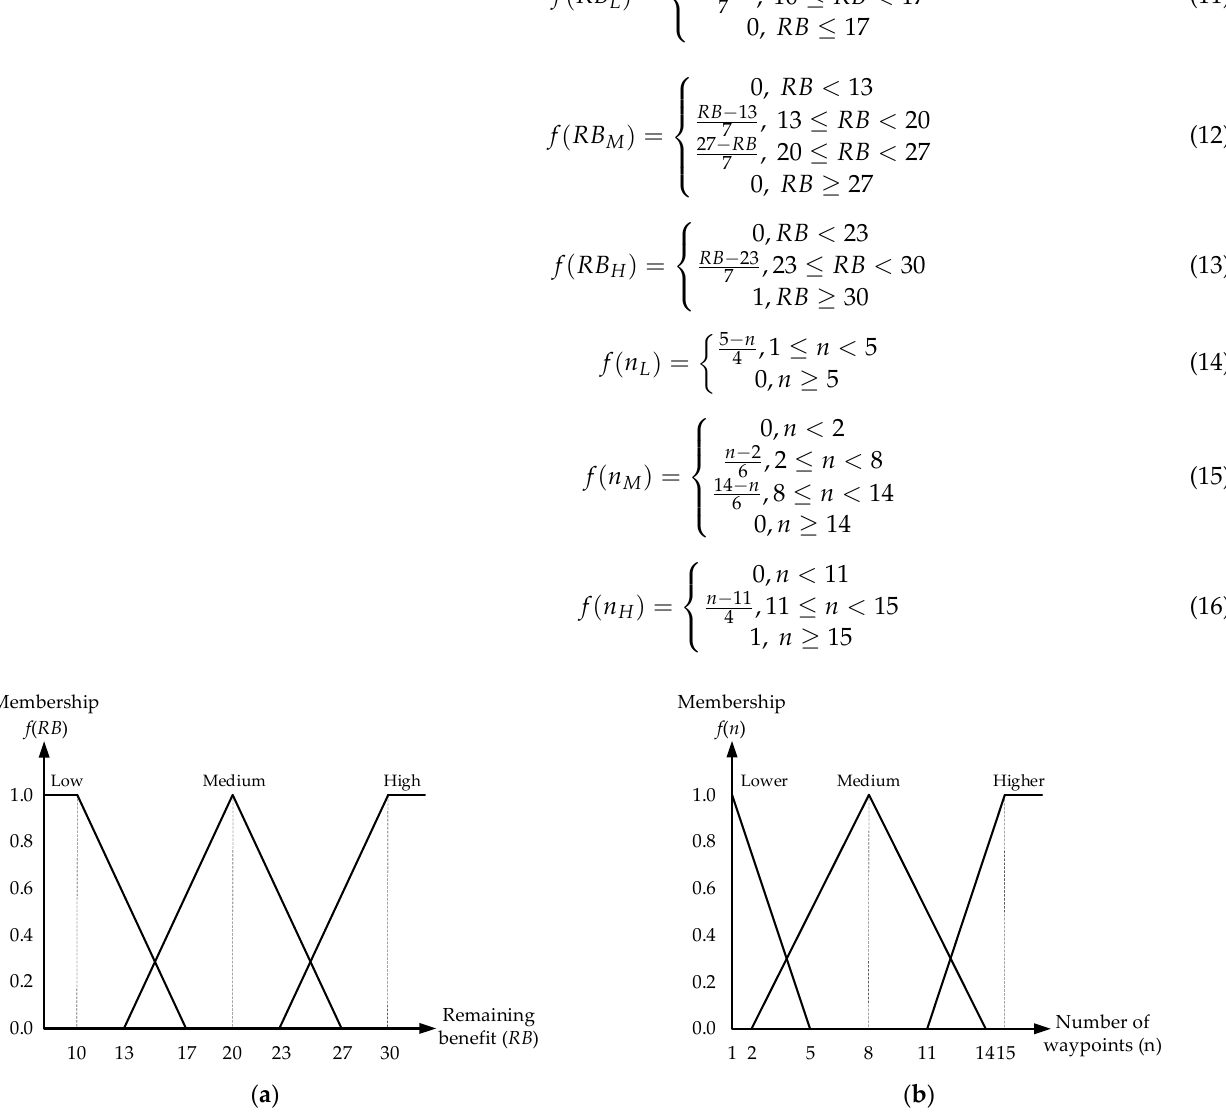
Figure 4. Schematic diagram of the FL method process.